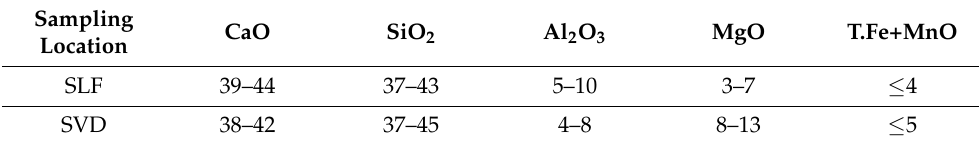
Table 2. Chemical composition of the refining slag, wt%.